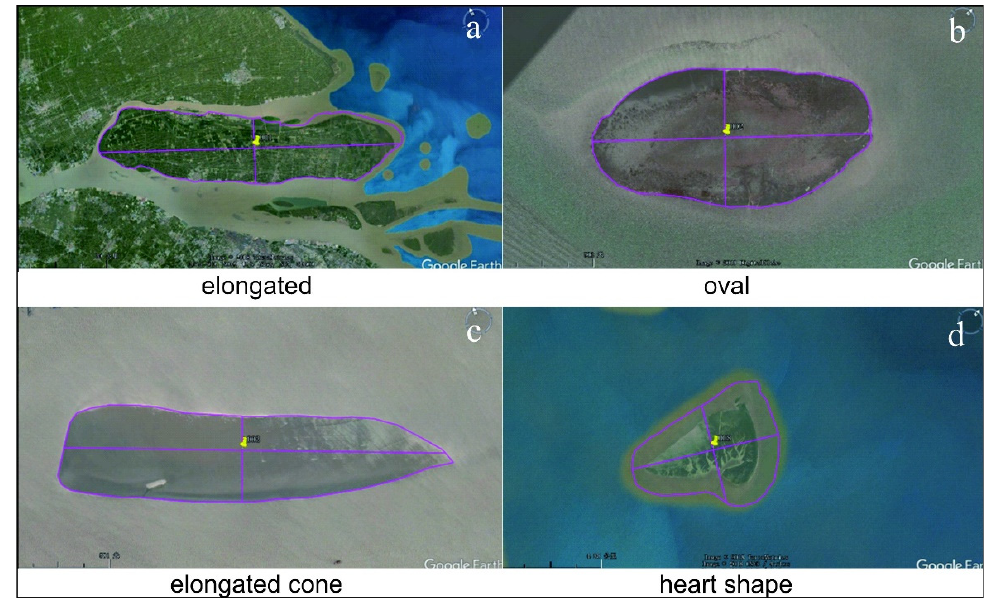
Figure 5. Examples of the shape and measuremnt of morden sandbars. Table 1. Detailed measurements of modern sandbars.